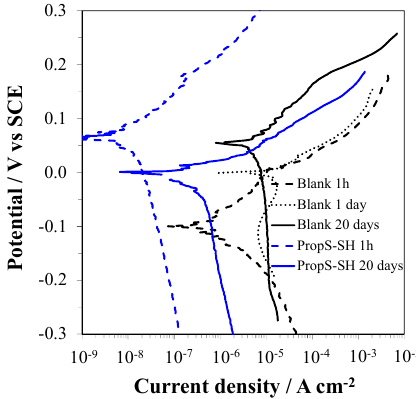
Figure 4. Polarization curves recorded on bare bronze and PropS-SH coated bronze after different immersion times in AR × 10 at 30 °C.